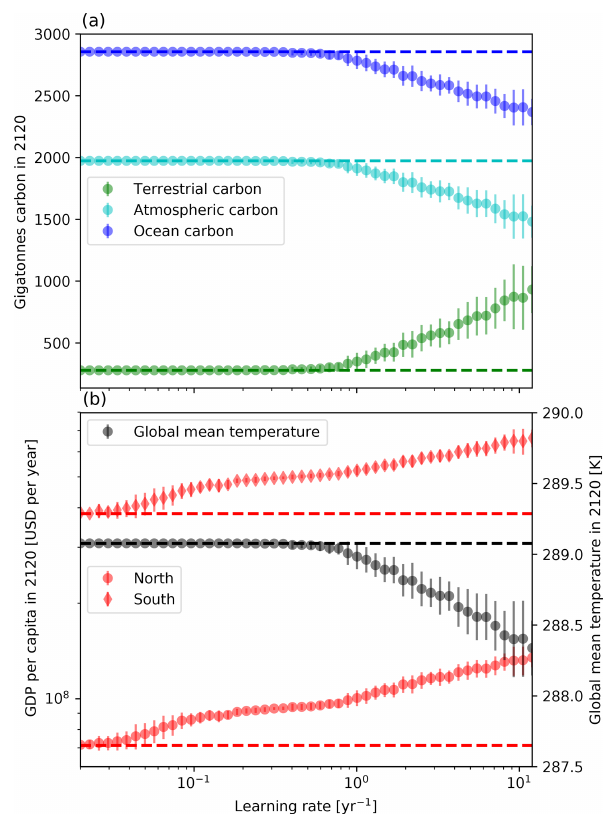
Figure 6. Dependency of some selected variables after 120 model years on the learning rate of environmental awareness. Scatter points denote (the average over 50) simulations with social pro- cesses, and error bars denote 1 standard deviation for each choice of learning rate. Dashed lines indicate the corresponding values for a simulation without social processes. Panel (a) shows the three envi- ronmental (non-fossil) carbon stocks; panel (b) shows the GDP per capita in the two social systems as well as the global mean temper-